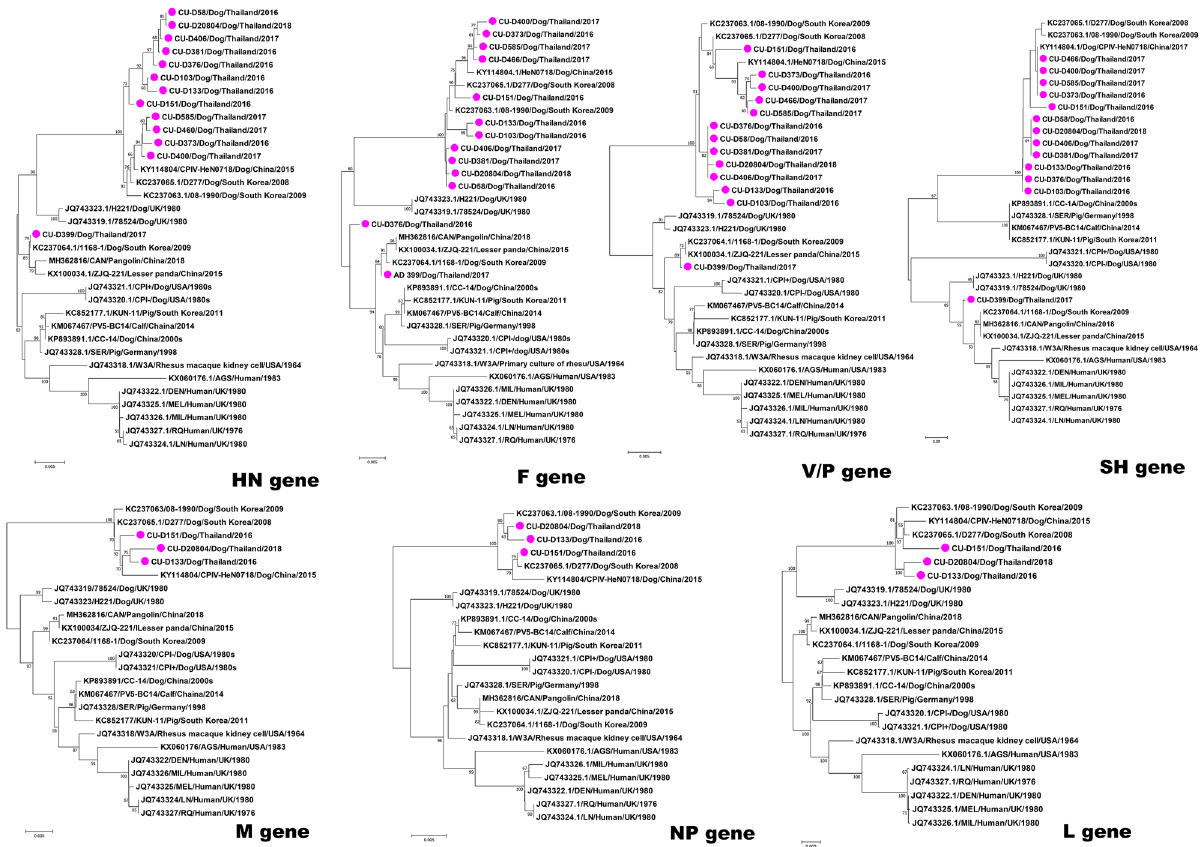
Figure 2. Phylogenetic trees of the HN, F, M, V/P, NP, and L genes of Thai CPIV-5 and reference PIV-1-5. Pink circles indicate Thai CPIV-5 in this study. The phylogenetic tree was constructed by using MEGA v.7.0